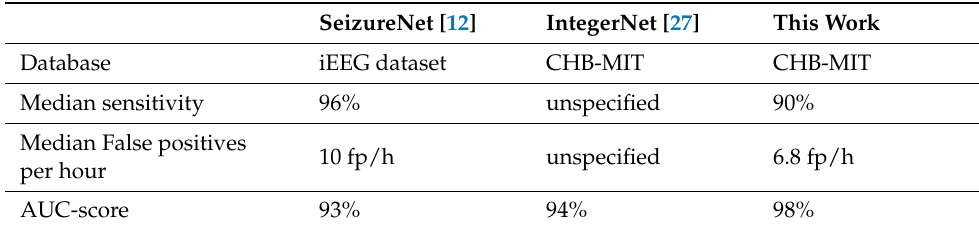
Table 1. Comparison of the overall classification performance of the developed approach with published work.